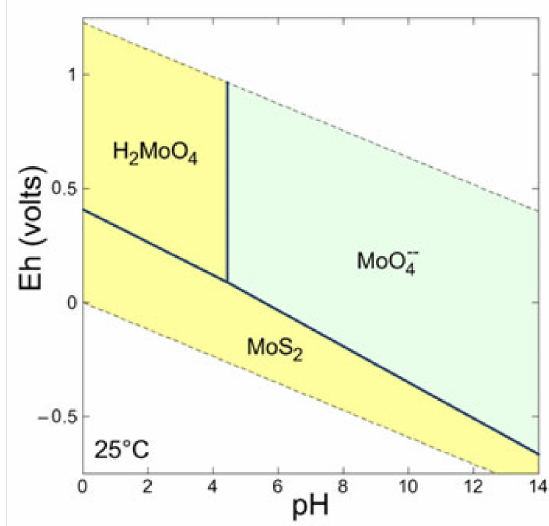
Figure 2. Eh-pH diagram of Mo-S-H 2 O system at 25 ◦ C and 1